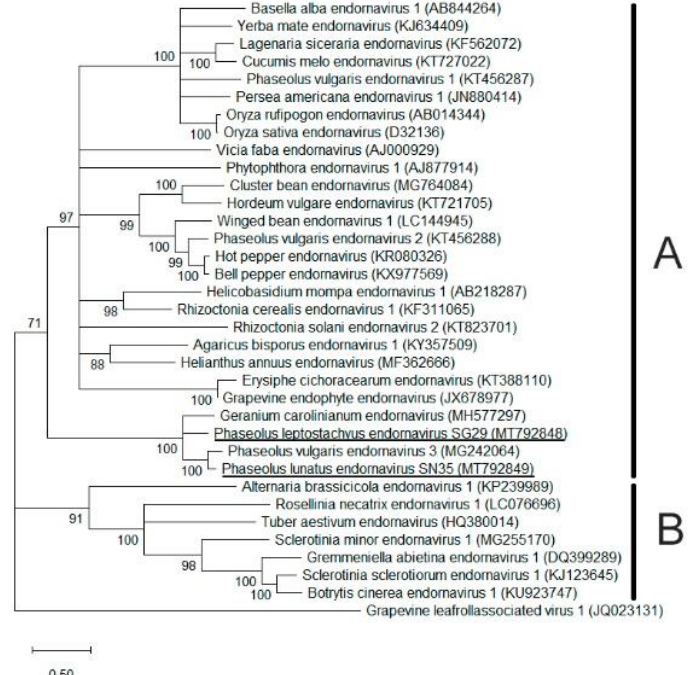
Figure 5. Phylogenetic tree of putative new alphaendornavirus PlepEV and PluEV: ( A ) Alphaen- dornavirus clade and ( B ) Betaendornavirus clade. Phylogenetic trees were constructed using an alignment of the amino acid sequences of the RdRp domains with the Maximum-Likelihood (LG + G + I model) with 1000 bootstraps. Grapevine leafroll-associated virus 1 (genus Ampelovirus, family Closteroviridae) was included as an outgroup. Nodes with less than 70% bootstrap values are collapsed. PlepEV and PluEV are underlined.